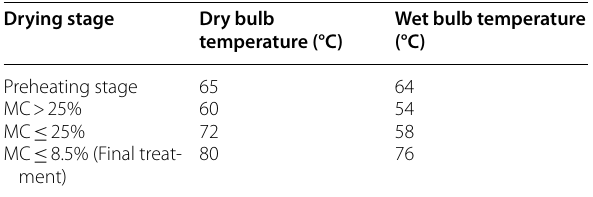
Table 1 Drying schedule for 50 mm-thickness Chinese fir lumber Drying